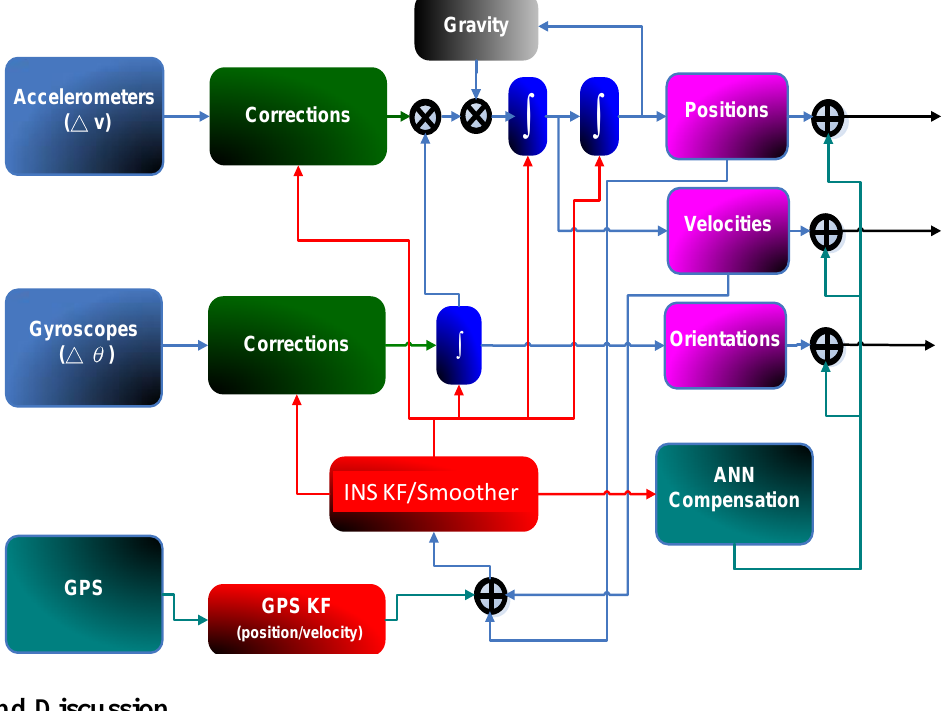
Figure 16. The implementation of ANN embedded KF and smoother (adopted from